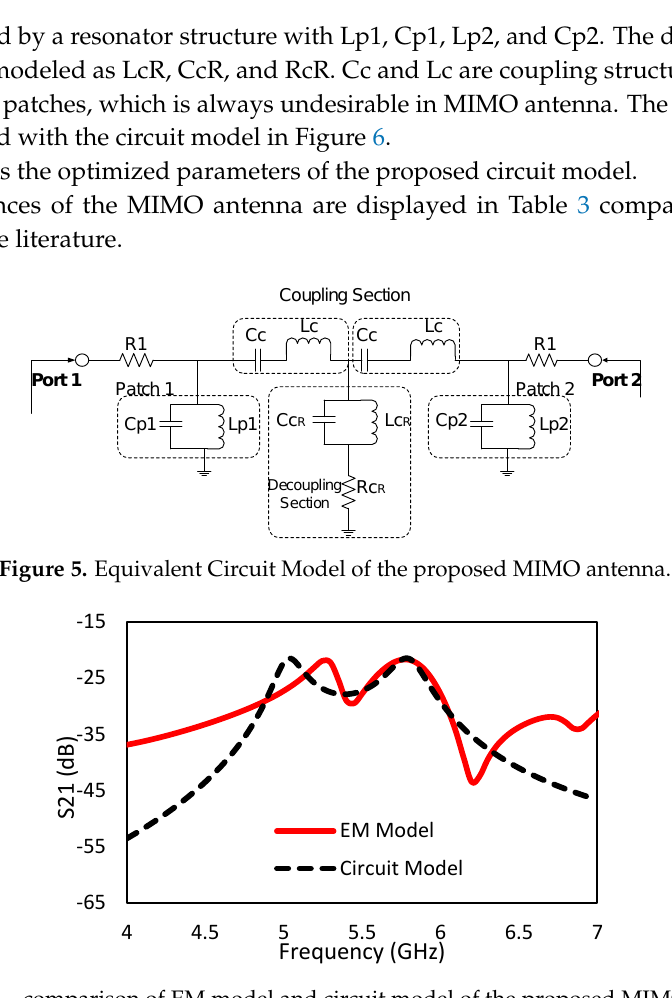
Figure 6. S 21 comparison of EM model and circuit model of the proposed MIMO antenna. Table 2. Optimized parameters of the circuit model.